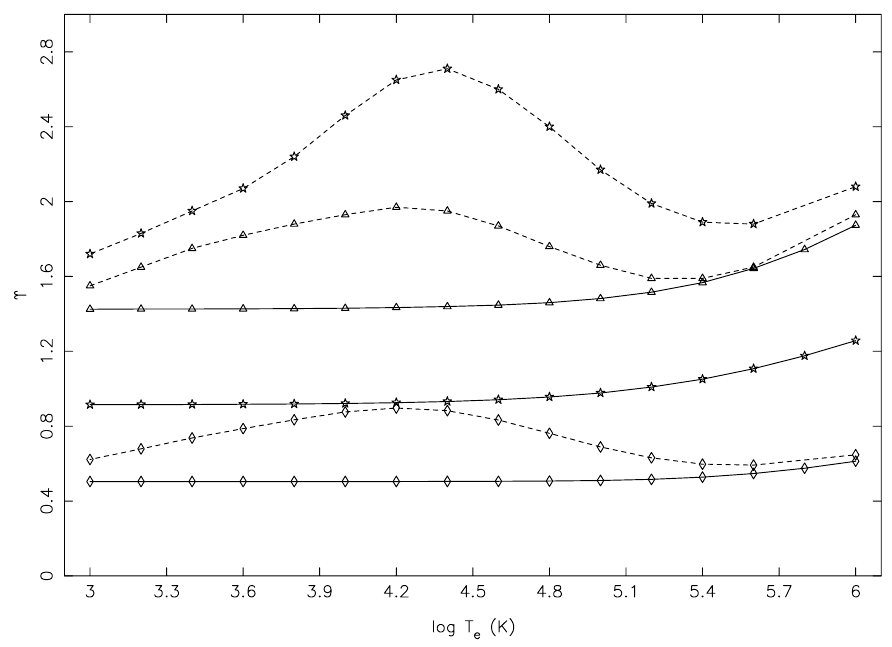
Figure 6. Comparison of FAC and BSR values of Υ for the 3–10 (triangles: 3p 2 3 P 2 –3s3p 3 ( 2 P) 3 P o (diamonds: 3p 2 3 P 2 –3s3p 3 ( 2 P) 3 P o